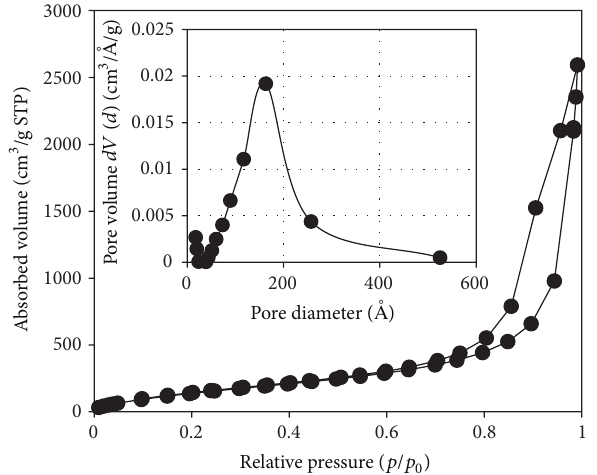
Figure 8: N 2 adsorption-desorption (BET isotherm) and BJH pore size distribution (inset, derived from absorption branch) of the aerogel materials.